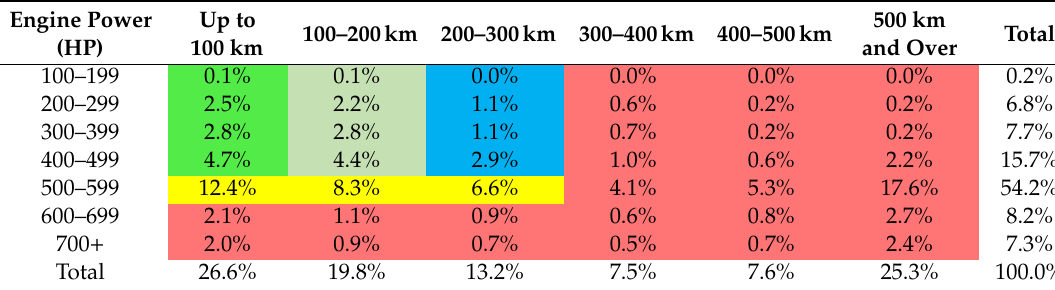
Table 3. Distribution of daily mileages for trucks ≤ 5 years old, for di ff erent engine powers. Shares in total vehicle mileage. Source: Base data of Statistics Norway’s ‘survey of trucks’ for 2016 and 2017